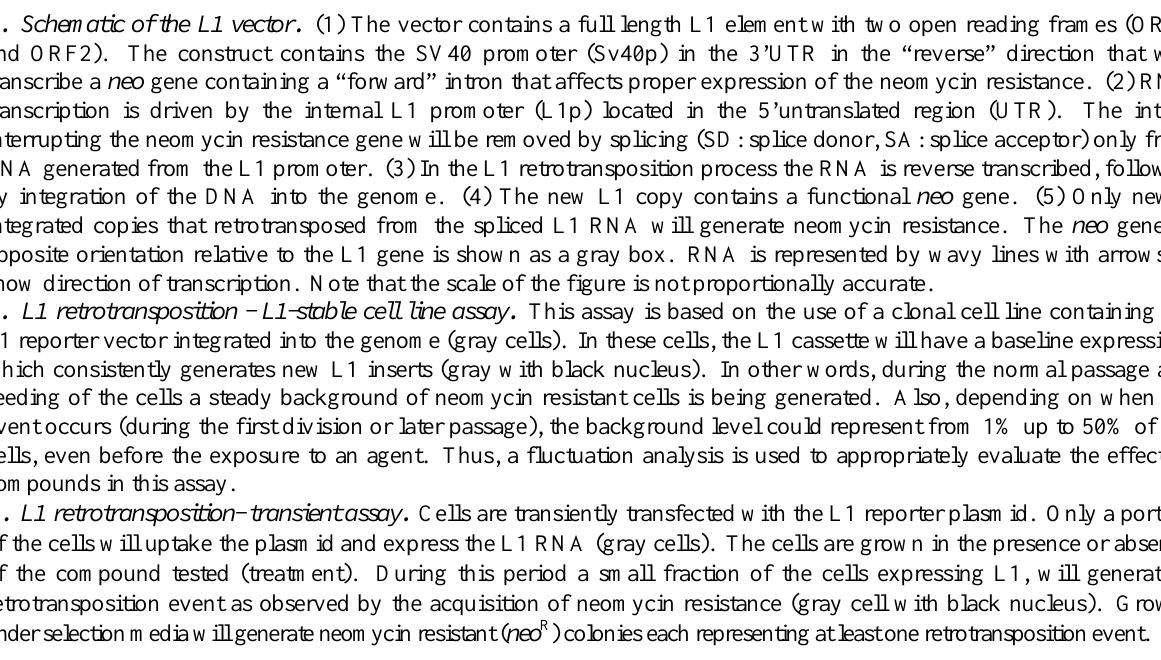
Figure 1: The L1 assay